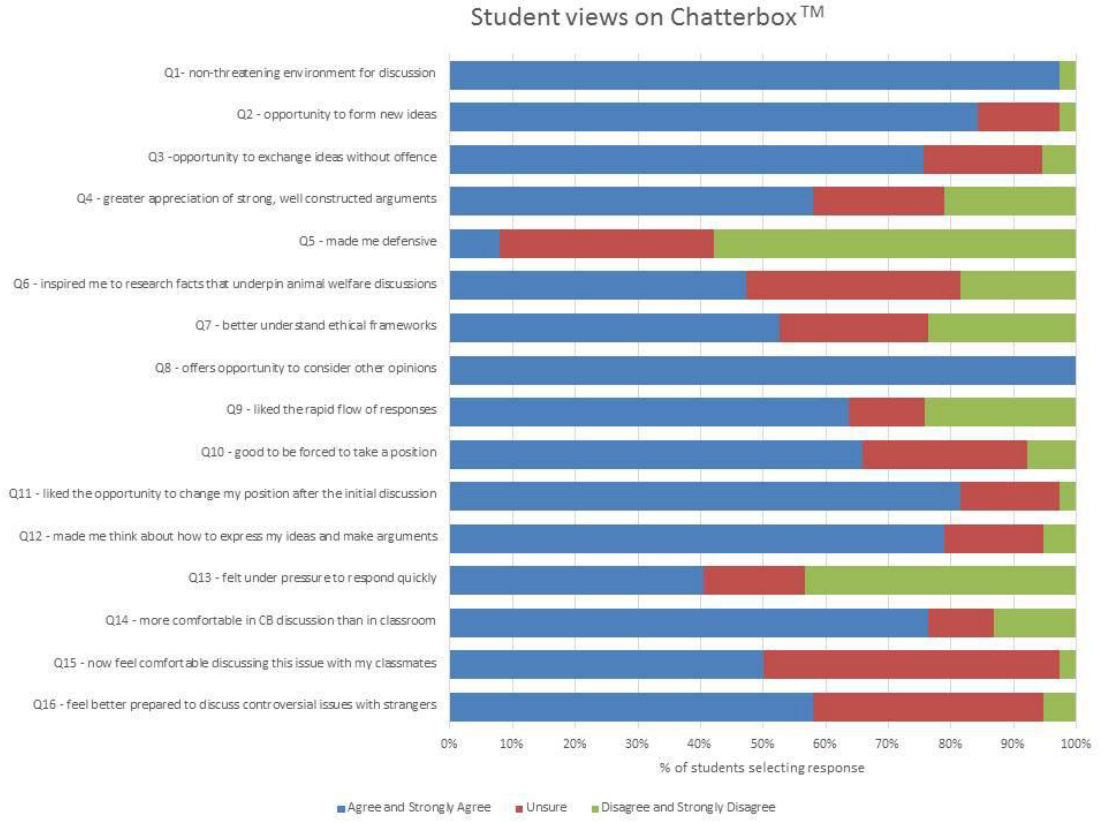
Figure 4. Student feedback on Chatterbox TM .